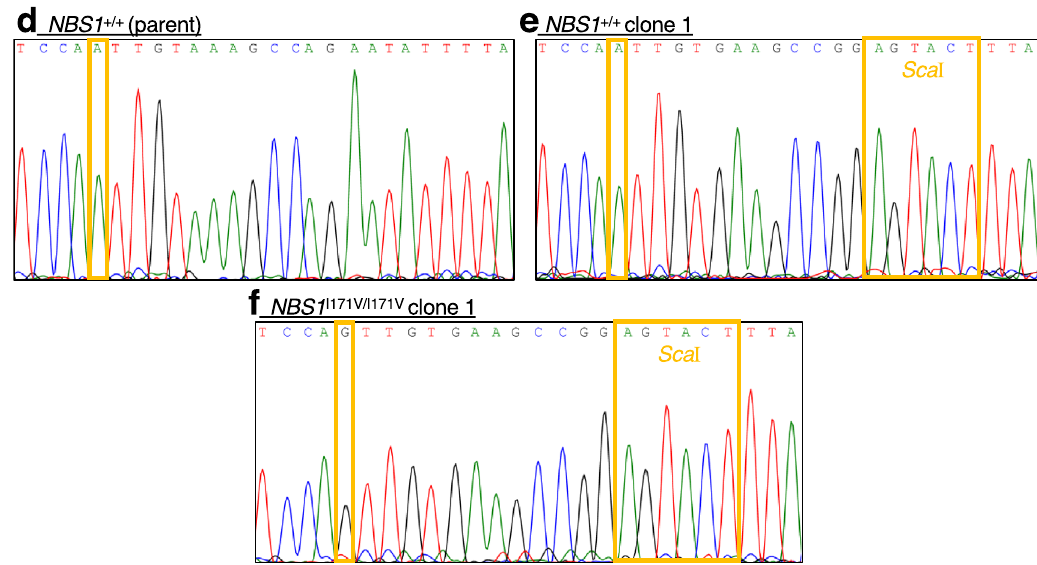
Figure 1. Generation of NBS1 I171V knock-in HCT-116 cells. ( a ) Structure of human NBS1 protein. NBS1 contains FHA and BRCT1/2 domains at the N terminus and several DNA repair protein-binding regions at the C terminus. FHA and BRCT1/2 domains are involved in the IR-induced nuclear foci with phosphoproteins such as γ-H2AX. NBS1 I171V is located in the BRCT1 domain. ( b ) Sanger sequencing confirmed NBS1 I171V heterozygosity in ovarian cancer patient 18. ( c ) Targeting strategy for NBS1 I171V knock-in using the CRISPR/ Cas9 system. Blue bases indicate silent mutations. ( d – f ) Sanger sequencing of NBS1 +/+ parental HCT116 cell ( d ), NBS1 +/+ -edited HCT116 cell clone 1 ( e ), NBS1 I171V/I171V -edited HCT116 cell clone 1 ( f ). A single base substitution of the NBS1 I171V variant and a silent Sca I site are indicated by yellow